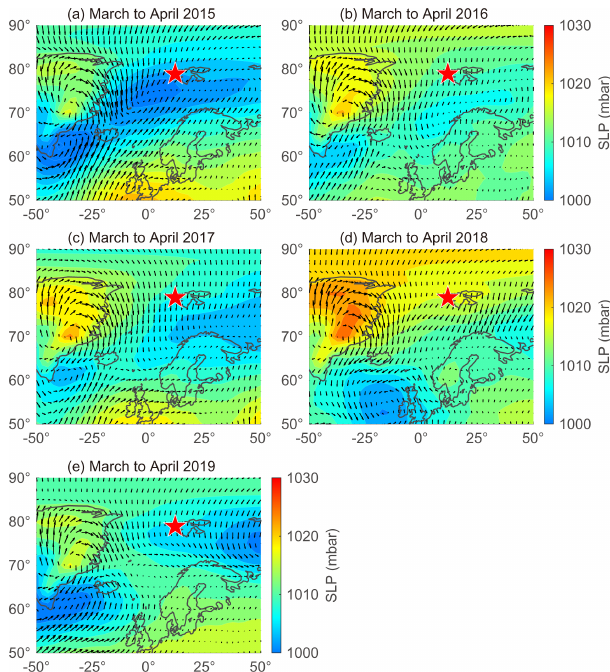
Figure 6. Sea level pressure (SLP) overlaid with wind vectors dur- ing March to April in (a) 2015, (b) 2016, (c) 2017, (d) 2018, and (e) 2019. Red stars indicate the location of the sampling site (Gru- vebadet observatory; 78.9 ◦ N, 11.9 ◦